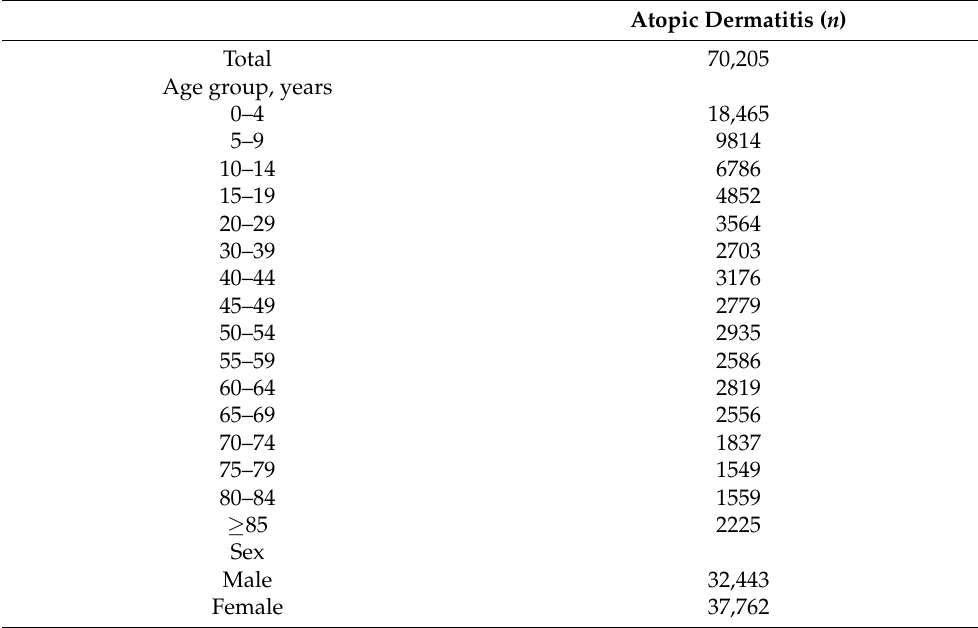
Table 1. Demographics of the study population.